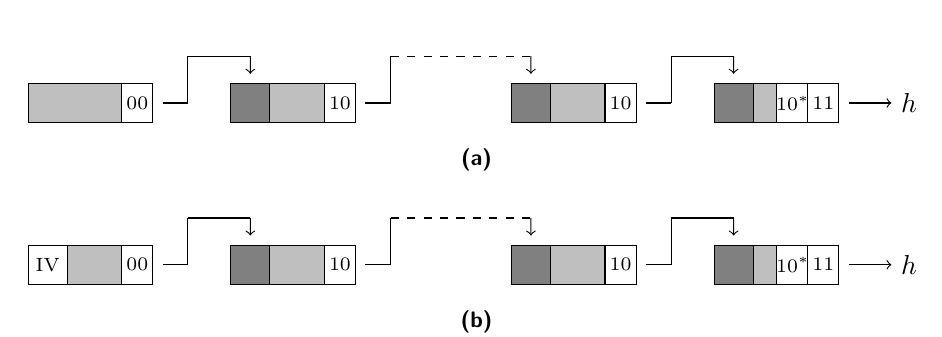
Figure 6: Tree template of a minimal sequential hashing mode of (a) an arbitrary function and (b) a truncated permutation or block cipher. White blocks contain frame bits, light gray blocks contain message pointer bits, and dark gray chaining blocks contain chaining pointer bits. See Section 8.2 on the possibility of omitting the first frame bit in case